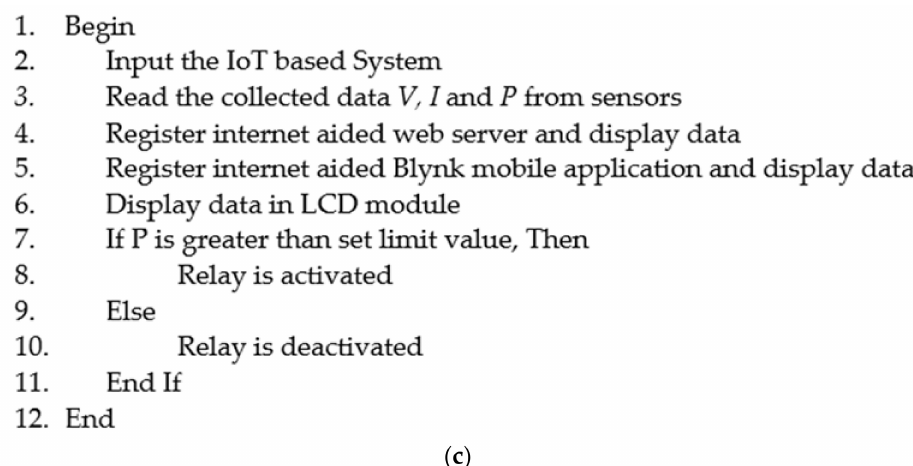
Figure 1. Proposed ISHDB system. ( a ) Schematic overview, ( b ) Flowchart, and ( c ) Pseudocode of the proposed method.